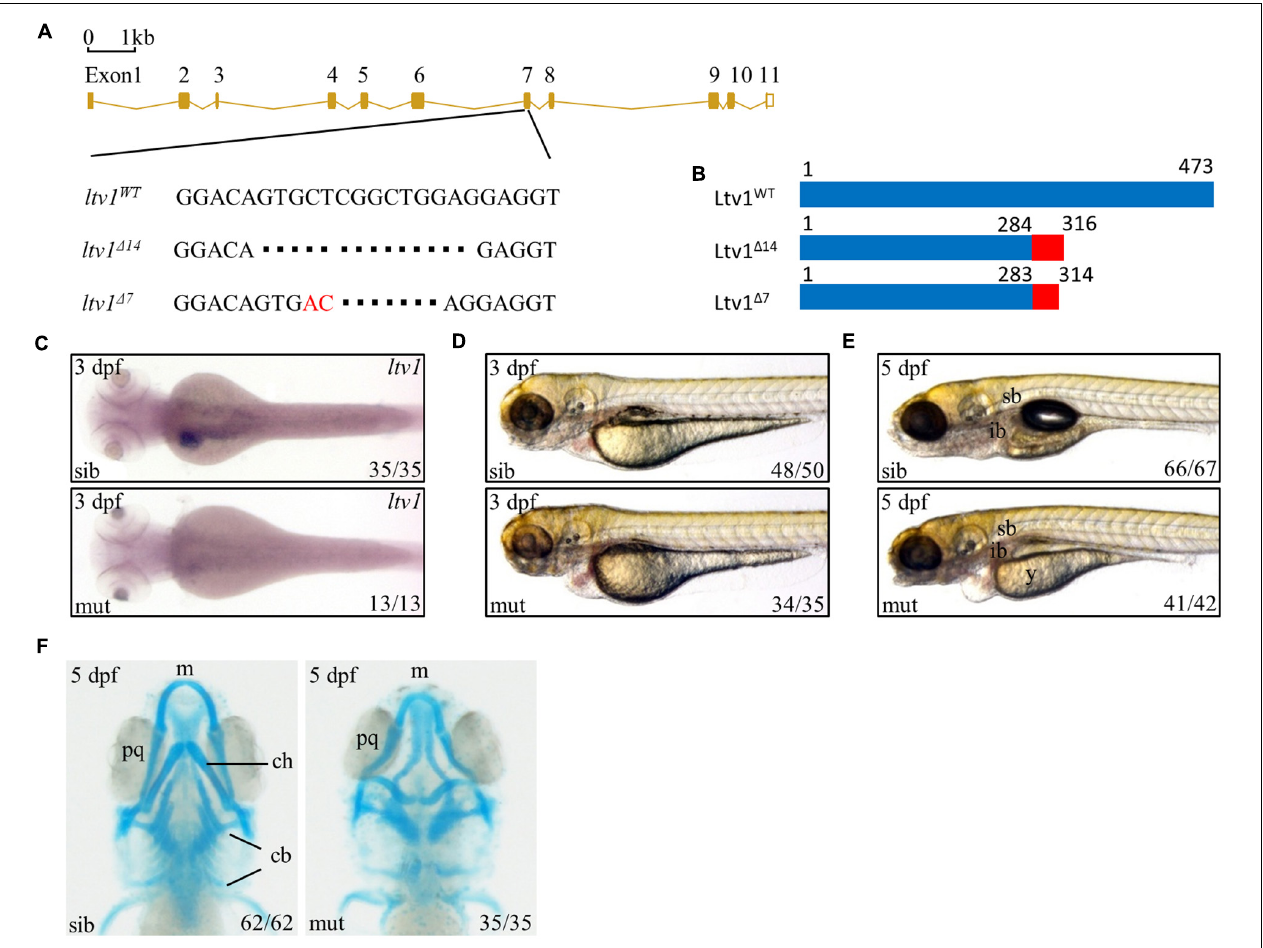
FIGURE 1 | Knockout of ltv1 and craniofacial defects in ltv1 ∆ 14 /∆ 14 mutant. (A) The sequences flanking the deletion site in ltv1 mutants ( ltv1 ∆ 7,14 ) are shown. The deleted nucleotides are denoted by dashes. In ltv1 ∆ 7 /∆ 7 mutant, 9 bp nucleotides are deleted and 2 bp nucleotides (red font) are inserted. (B) Two ltv1 mutant alleles ( ltv1 ∆ 14 and ltv1 ∆ 7 ) harbor frameshift mutations that are predicted to give rise to truncated Ltv1 proteins as shown. (C) WISH using ltv1 antisense RNA probe at 3 dpf. (D,E) Representative images of ltv1 ∆ 14 /∆ 14 mutants and siblings at 3 and 5 dpf. (F) Alcian blue-labeled craniofacial cartilage in ventral view at 5 dpf. Abbreviations used: sb, swimming bladder; ib, intestinal bulb; y, yolk; m, Meckel’s; pq, palatoquadrate; ch, ceratohyal; cb,